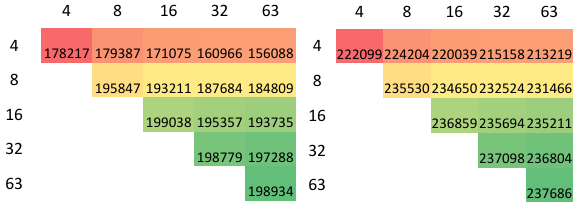
Table 4-5: Number of “good points” in the DTM for all combinations of compression factors in the image